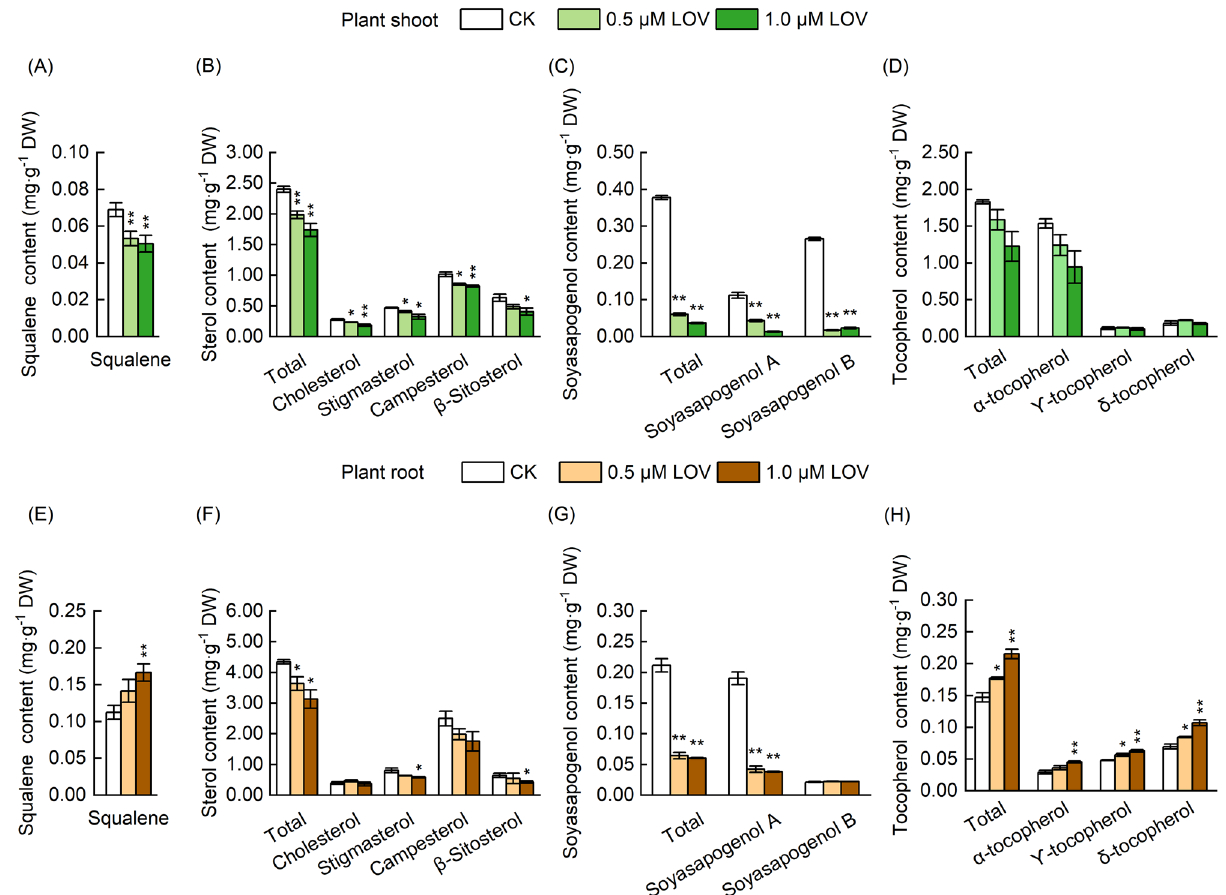
Figure 4. Content changes of isoprenoids in LOV-treated soybean seedlings. ( A ) Content changes of squalene, ( B ) sterols, ( C ) soyasapogenol, and ( D ) tocopherols in plant shoot after LOV treatment. ( E ) Content changes of squalene, ( F ) sterols, ( G ) soyasapogenol, and ( H ) tocopherols in LOV-treated plant root. The data represent the mean ± SE of three biological replicates; the symbol * denotes significant difference from CK at p < 0.05; ** at p < 0.01 by Student’s